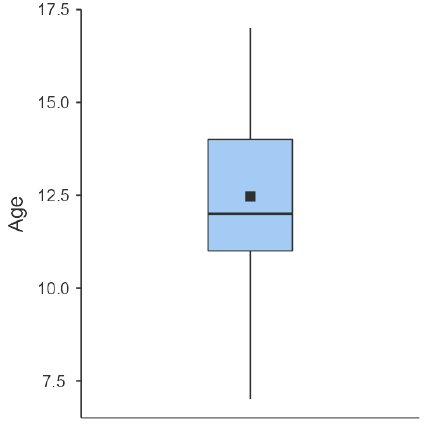
Figure 1. Age distribution box plot.